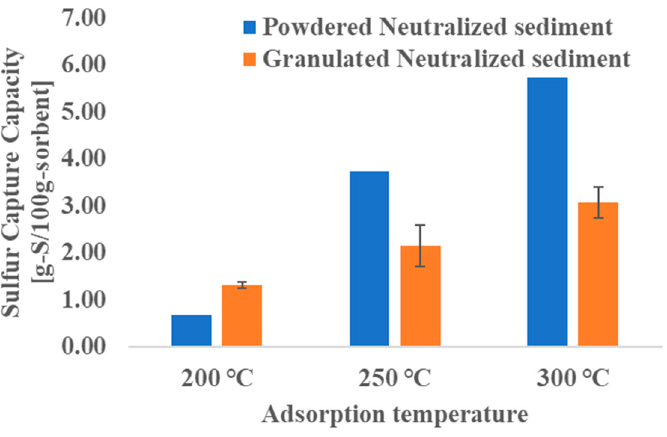
Figure 5. Results of dynamic adsorption